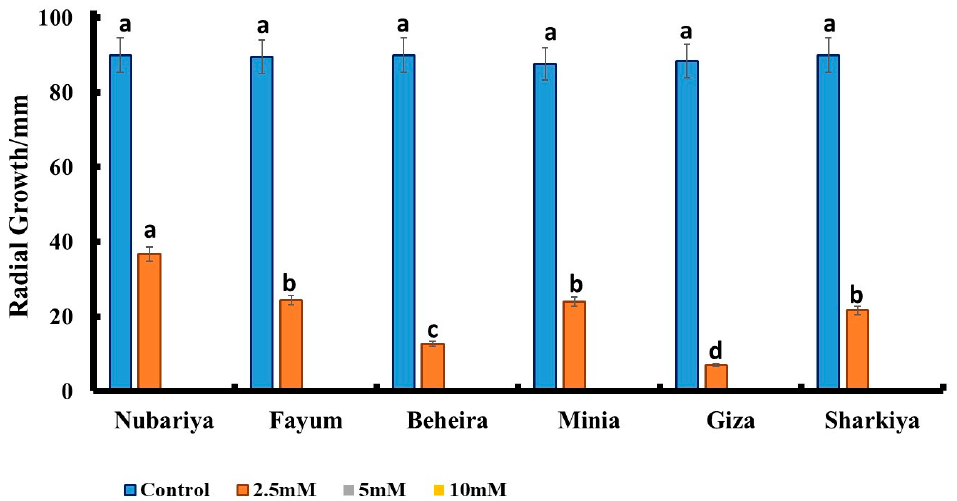
Figure 7. Effect of different concentrations (2.5 mM, 5 mM, 10 mM) of nano-chitosan on the growth of H. maydis isolates from different origin sites at 7 days post-inoculation. All values are presented as a mean of five replicates + SE . a,b,c,d Estimates with the same letters are not significantly different ( p ˂ 0.05) among different isolate sources (governorates) for the same concentration.